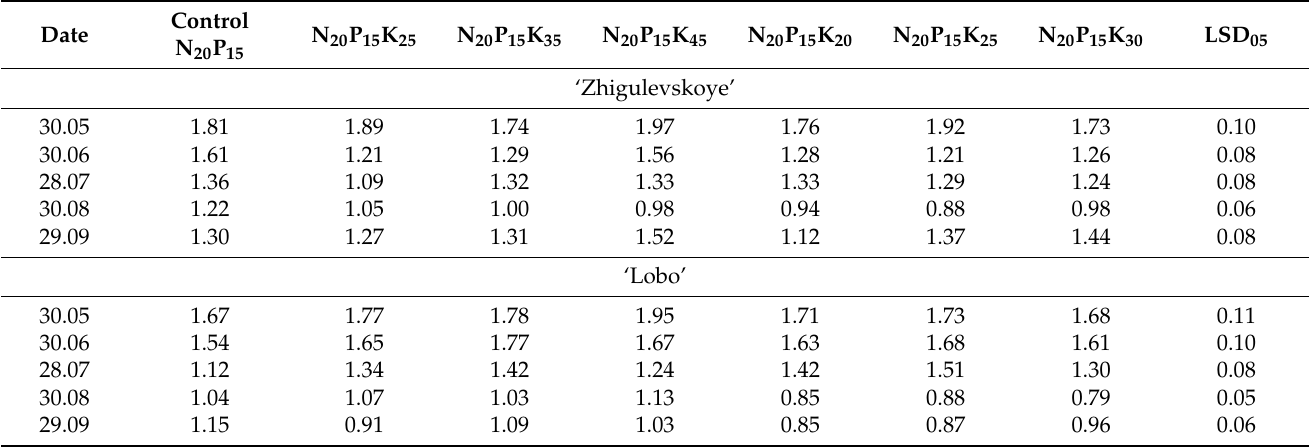
Table 3. Seasonal changes of leaf potassium content, % d.m.